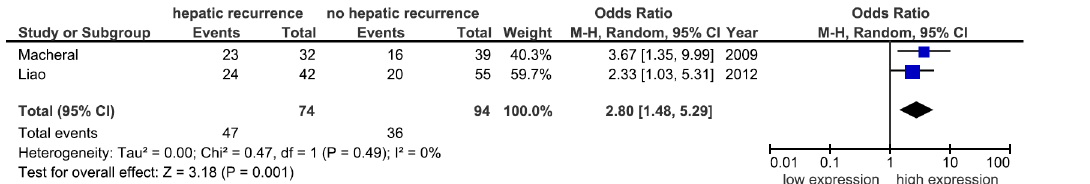
Fig 5. Association between CXCR4 and hepatic metastasis during follow up. Forest plot reflects the individual and pooled OR with CI to assess the association between CXCR4 and hepatic metastasis during follow up. Heterogeneity was quantified by the Cochrane Q test (Chi-squared test; Chi 2 ) and inconsistency (I 2